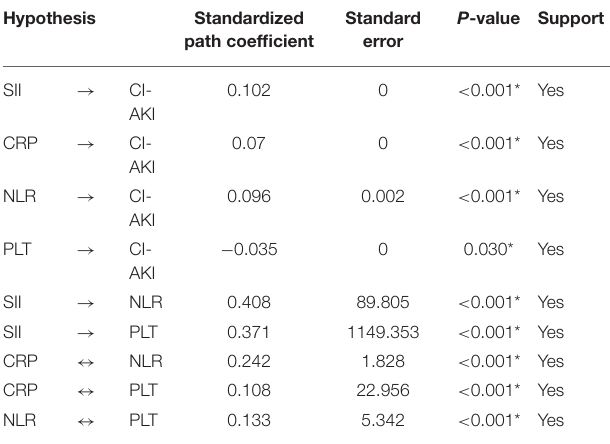
TABLE 4 | Results of structural equation modeling analysis.